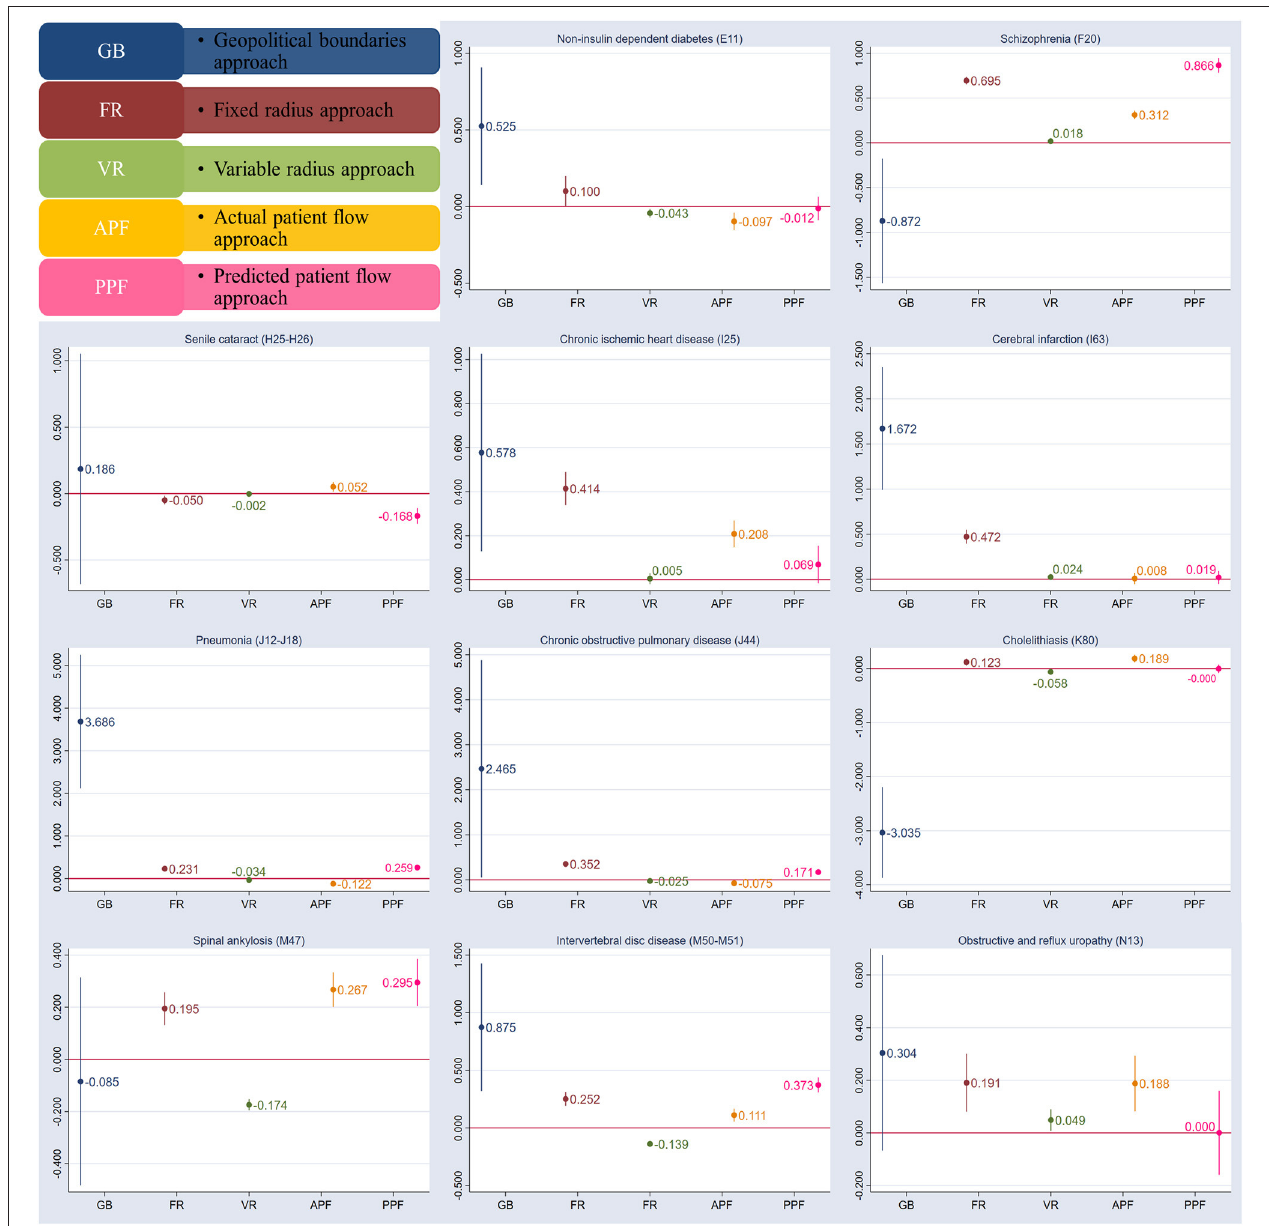
FIGURE 3 | Excluding the inpatients living outside of Sichuan Province: the parameter estimates of each HHI and its 95% confidence interval. in Sichuan hospitals were also included 10 . The